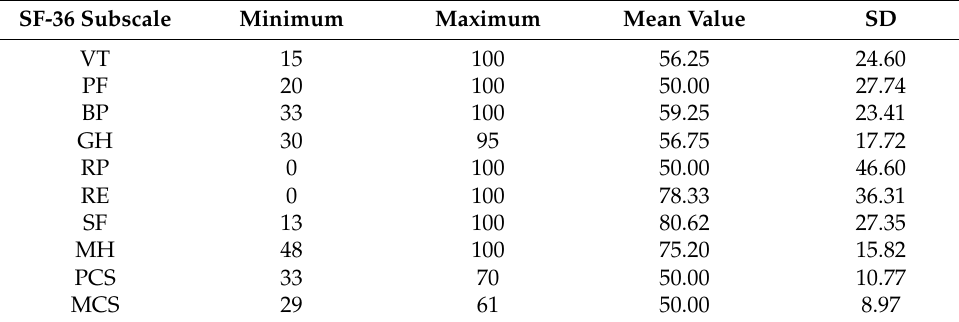
Table 3. Mean values of 36-Item Short Form